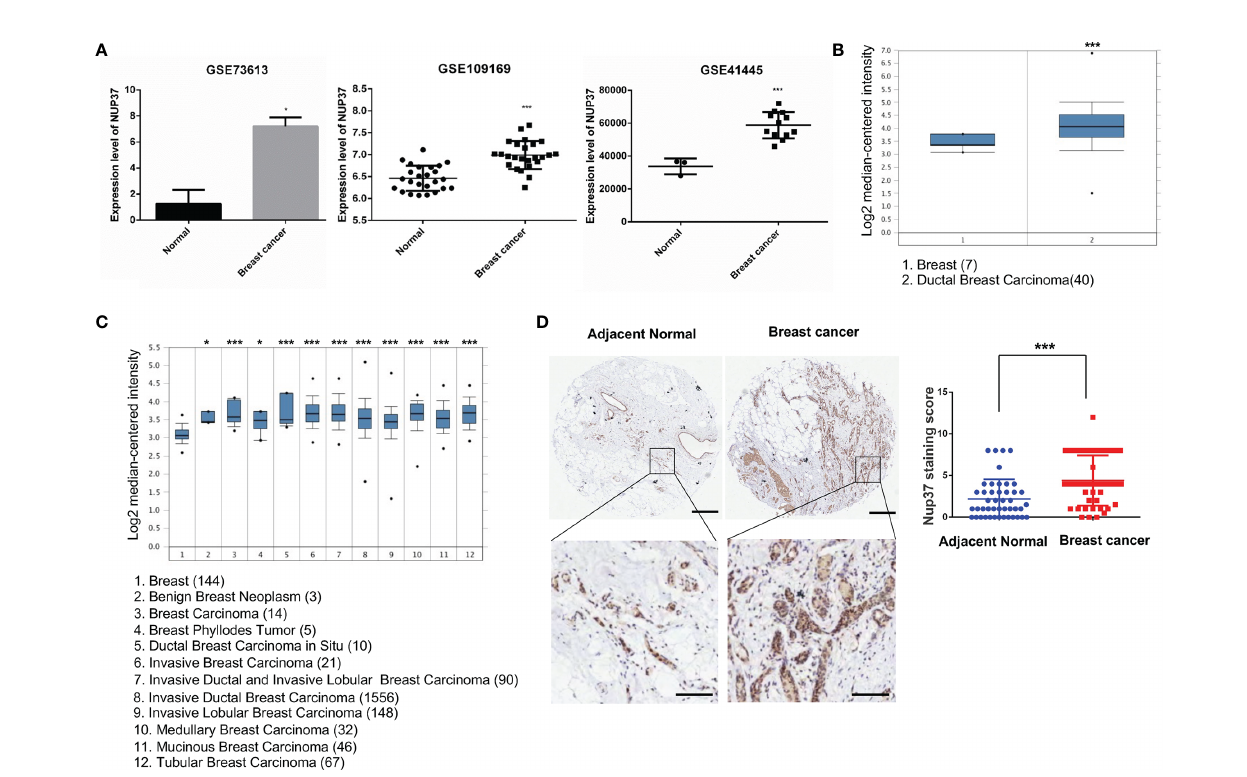
FIGURE 2 | The expression level of NUP37 in BRCA versus normal samples. (A) Expression level of NUP37 in BRCA and normal samples from GEO datasets (GSE73613, GSE109169, GSE41445) (Unpaired t test, Cancer VS. . Normal, p*<0.05, p***<0.001). (B) Oncomine data mining analysis of NUP37 mRNA levels in Richardson Breast 2 Dataset and (C) Curtis Breast Dataset between normal breast versus breast cancer subtypes. (Unpaired t test, Cancer VS . Normal, p*<0.05, p***<0.001) (D) Nup37 protein level in breast cancer tissue versus adjacent normal tissue for human tissue microarray staining of 45 patients. The representative image of staining tissue (left) and statistic staining score (right) (Unpaired t test, p***<0.001). Scale bar, 400 m m,above; 100 m m,